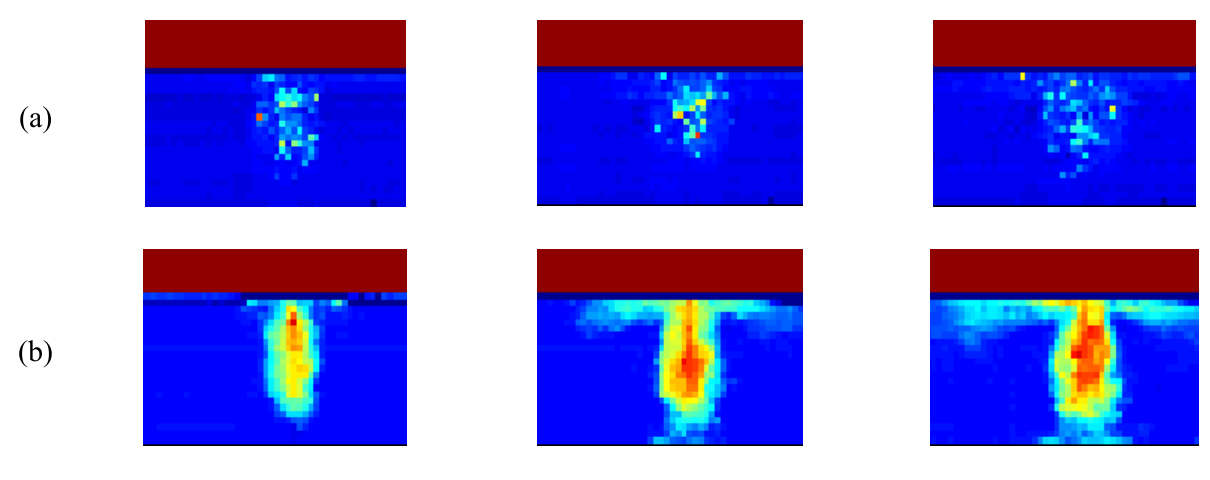
Figure 9 . Results of a simple plunging jet experiment. (a) Bubble detection experiment and (b) mixing process experiment. For simplicity the images were cropped to the region of